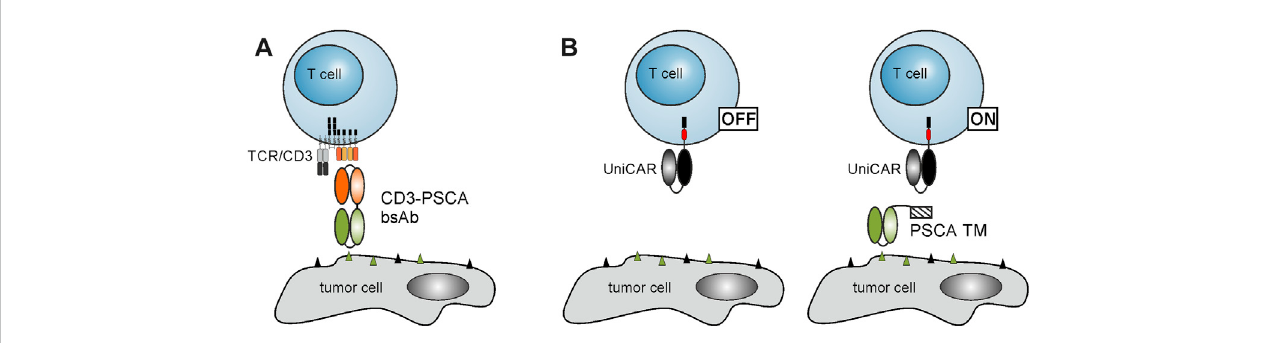
Schematic representation of T cell-based immunotherapies. (A) Due to its dual speci fi city for CD3 and PSCA, the CD3-PSCA bsAb is able to cross-link TcellsandPSCA-expressingtumorcells.Subsequently,Tcellsareactivatedandkilltherecognizedtargetcell. (B) TheUniCARsystemiscomposedofUniCAR